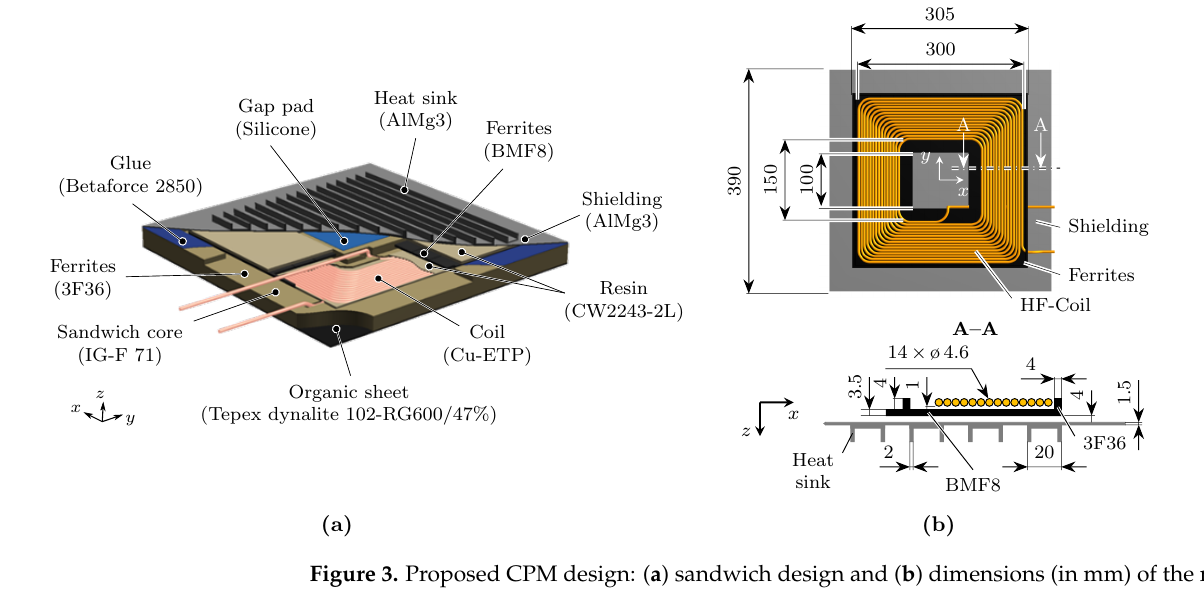
Figure 3. Proposed CPM design: ( a ) sandwich design and ( b ) dimensions (in mm) of the magnetic active components.